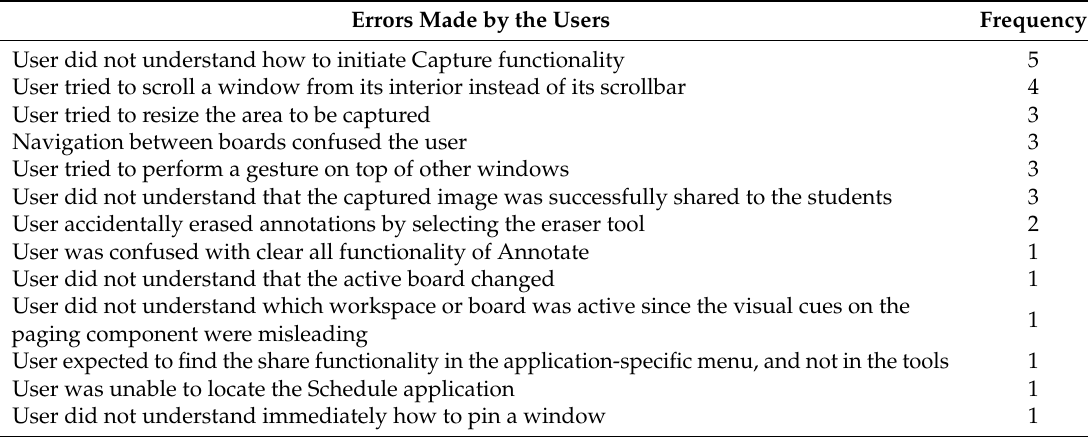
Table 6. The errors made during the evaluation.